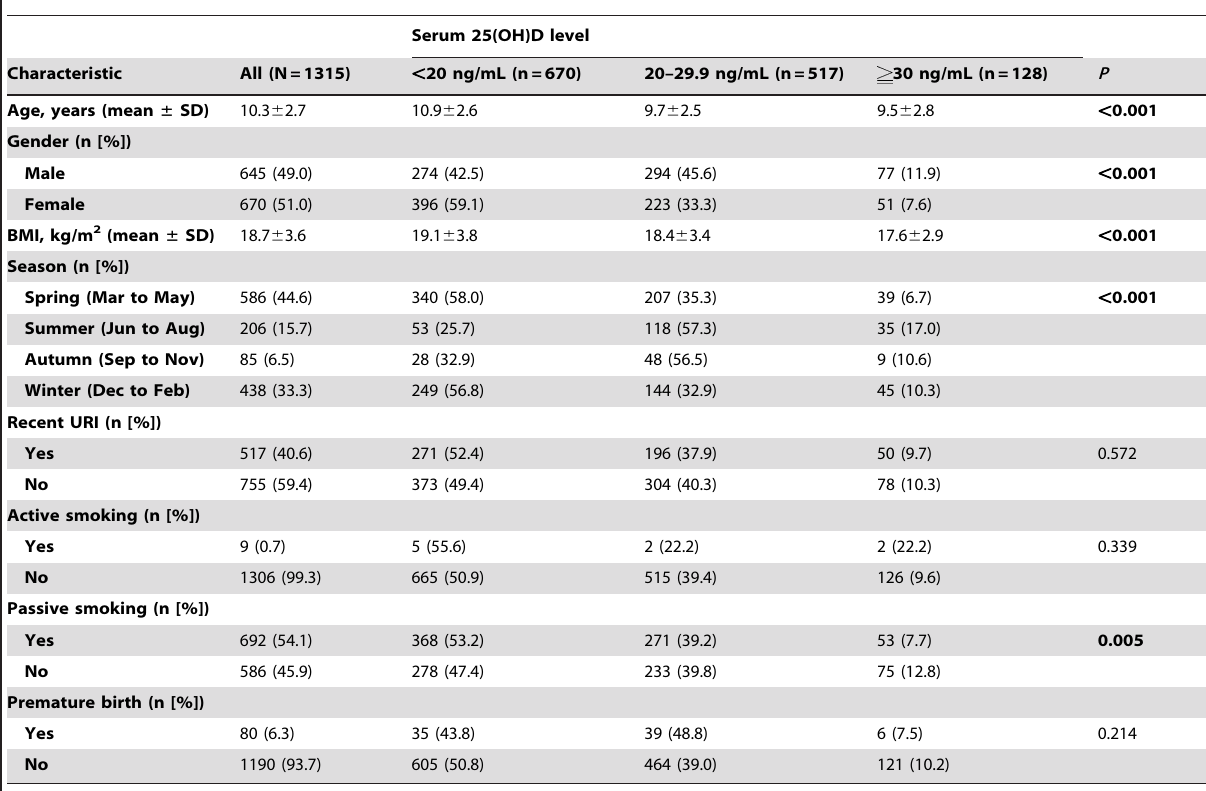
Table 1. Characteristics of 1315 subjects according to serum 25(OH)D levels.